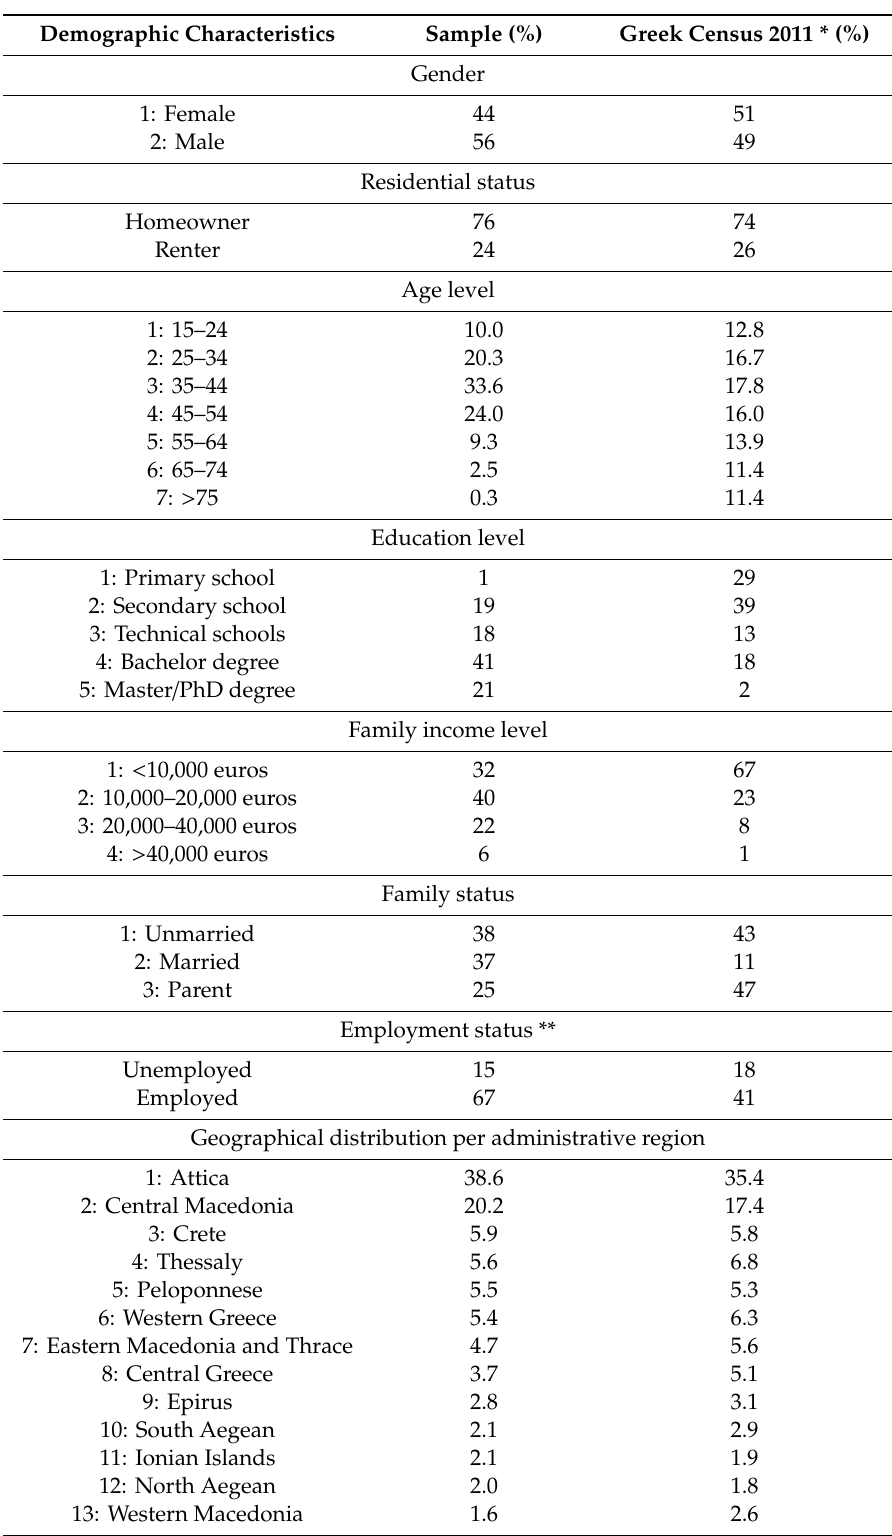
Table 1. Comparison of survey demographics to the Greek population. Demographic